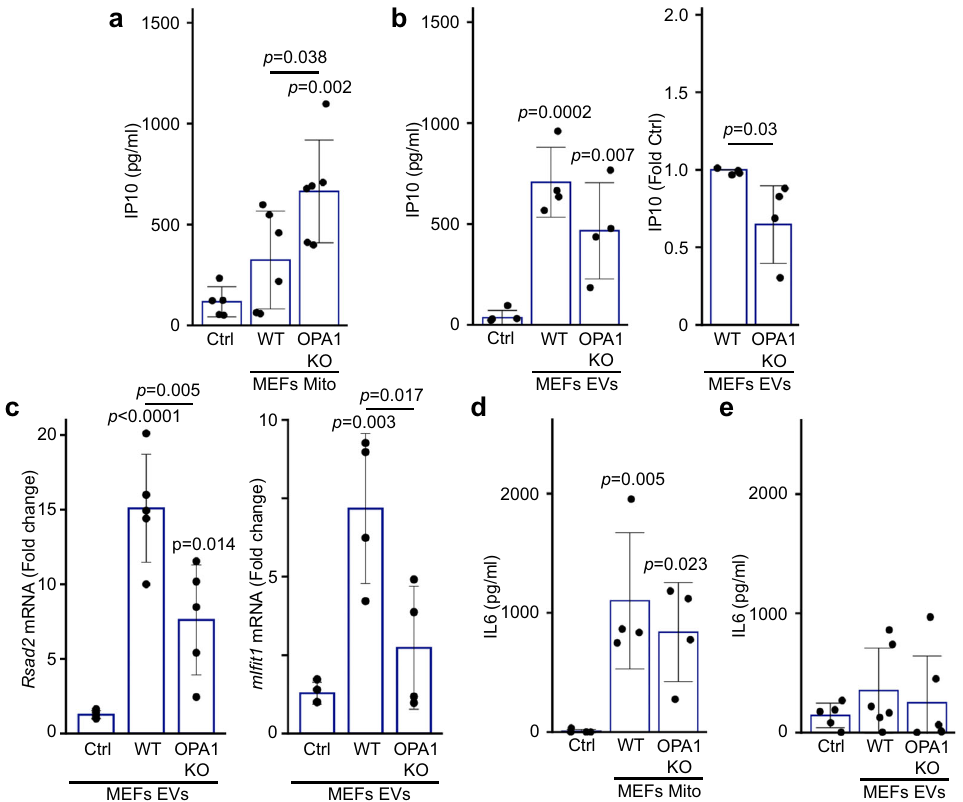
Fig. 6 OPA1 KO mitochondria but not EVs isolated from the same cells induce an IP10 in fl ammatory response. a , b RAW cells were treated as in Fig. 1 with mitochondria (Mito, 12 µ g) ( a ) or EVs (from 10 × 10 6 cells) ( b ) isolated from WT or OPA1 KO MEFs and IP10 release in culture media measured by ELISA. Individual points represent actual concentrations (or normalised to WT for ( b ), right panel) in independent experiments (Mito, n = 6; EVs, n = 4). Bars show the average ± SD. One-way ANOVA, two-sided t -test for ( b ), right panel. c OPA1 KO EVs show reduced expression of IFN-dependent genes. RAW cells were treated as in ( a – b ) and mRNA levels of the IFN-dependent genes Rsad2 (left) and mI fi t1 (right) measured by qPCR. Individual points represent independent experiments ( Rsad2 , n = 6; mI fi t1 , n = 4). Bars show the average ± SD. One-way ANOVA. d , e RAW cells were treated as in ( a , b ) and IL6 was measured in the culture media by ELISA. Individual points represent independent experiments (Mito, n = 4, EVs, n = 5). Bars show the average ± SD. One-way